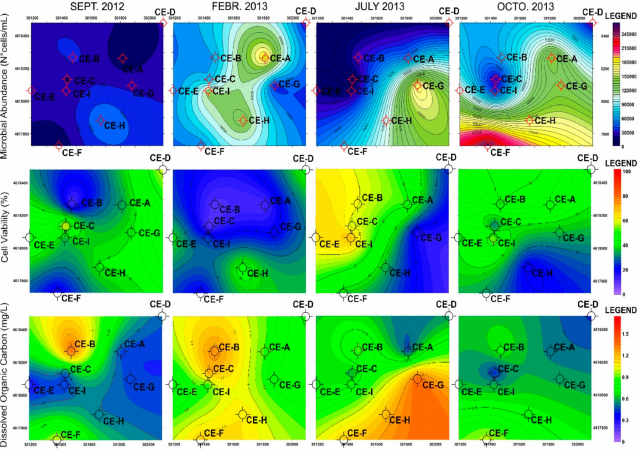
Figure 6. Geostatistical maps of microbial abundance (No. cells / mL), cell viability (%), dissolved organic carbon (mg / L) for each sampling campaign. The higher values are reported in red and the lower ones in